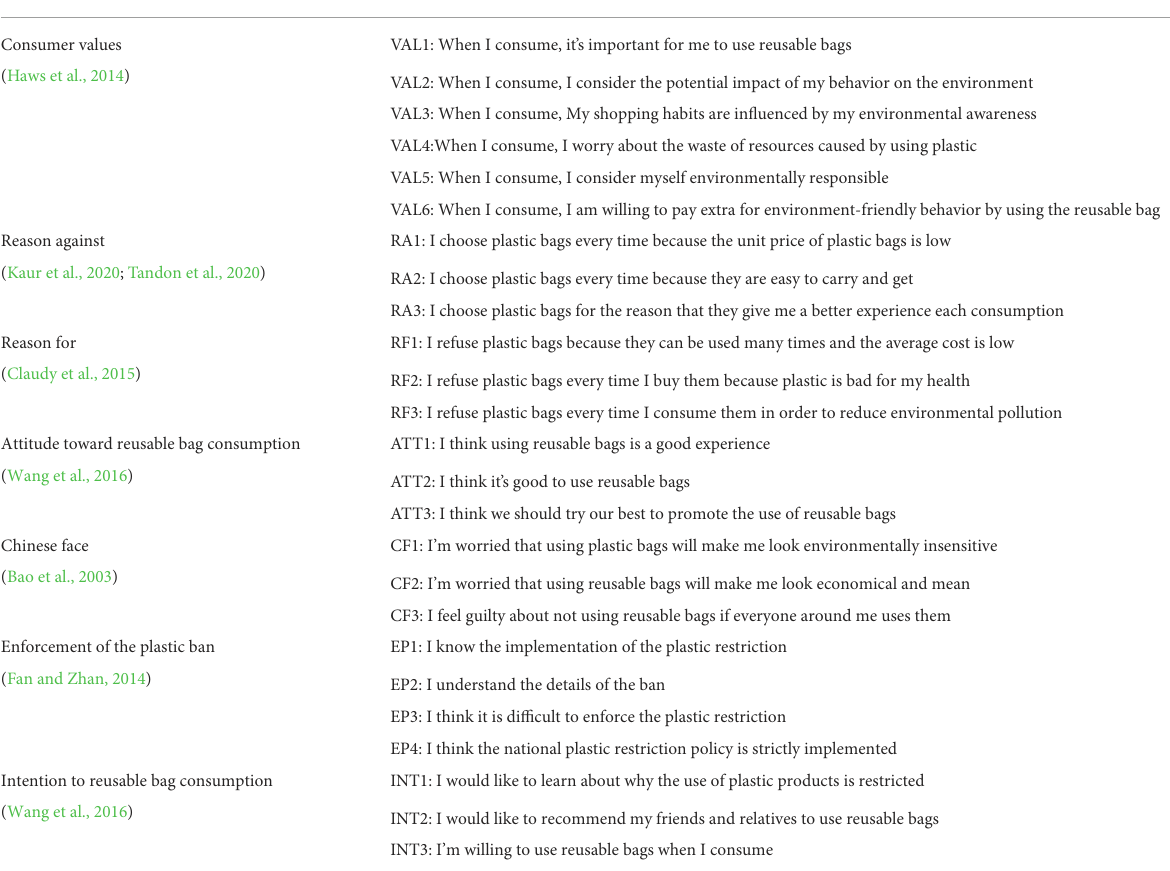
TABLE 2 Measurement scale related to generation plastic consumption (Lebreton and Andrady,